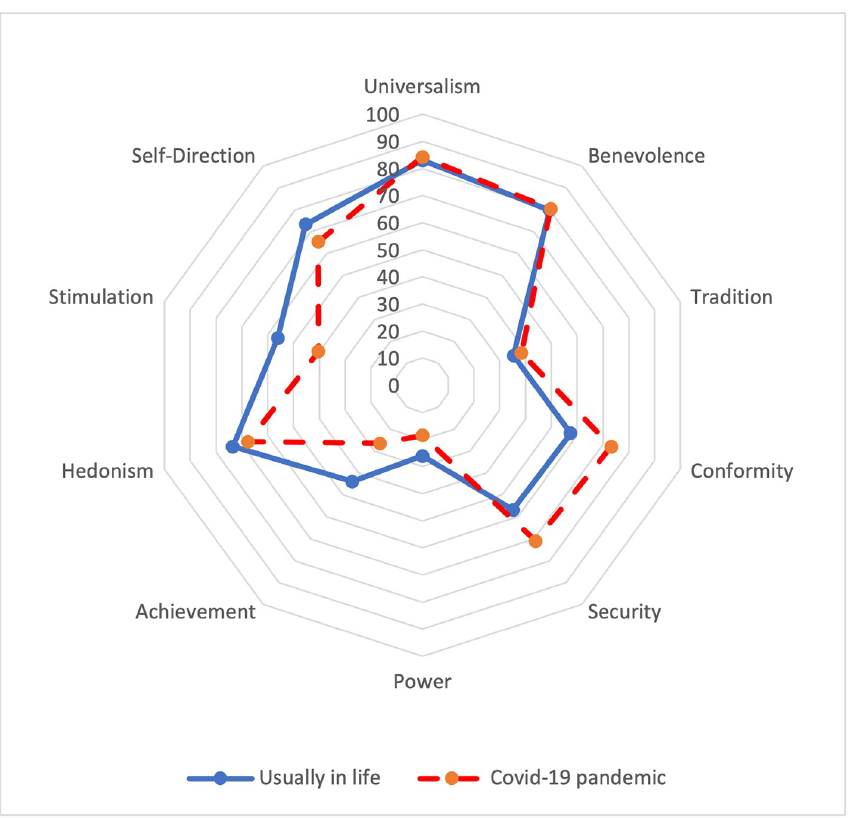
Fig 1. Magnitude of endorsement of Schwartz’ values (0: Not at all; 100: Completely, for each values) according to the response context (i.e., usually in life and during the Covid-19 pandemic).